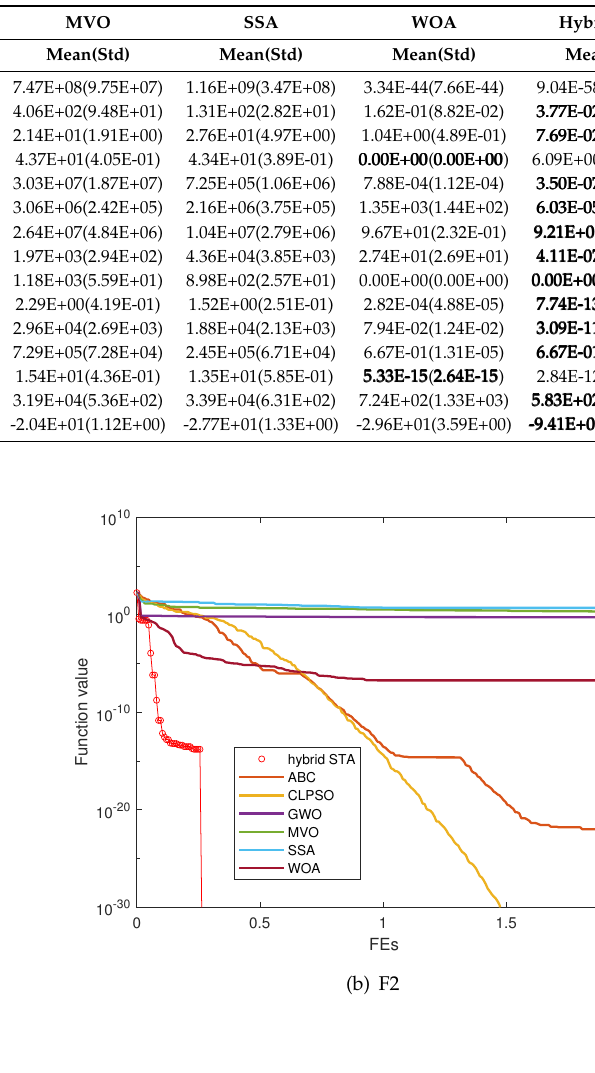
Table 6. Statistical results for different metaheuristic methods with D = 100.